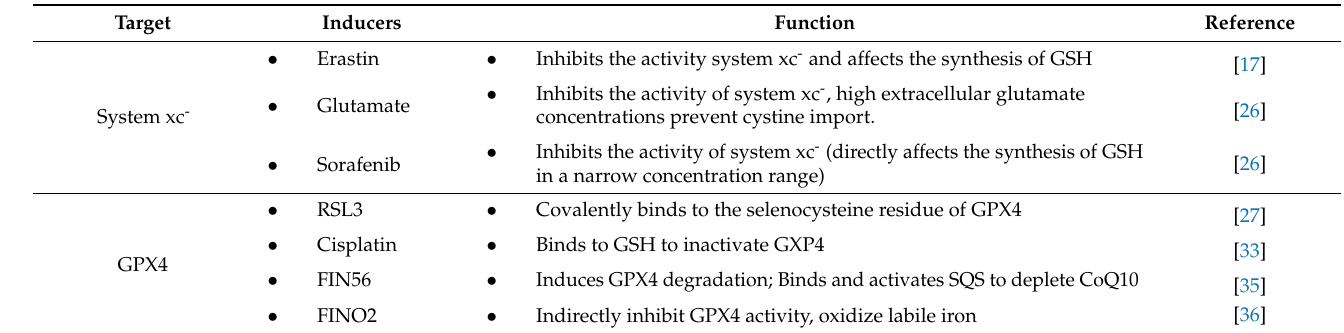
receptor 1; NCOA4, nuclear receptor coactivator 4; ATG5, autophagy-related 5; ATG7, autophagy-related 7; PUFAs, polyunsaturated fatty acids; PUFA-CoA, polyunsaturated fatty acyl-coenzyme a; PL-PUFA, polyunsaturated phospholipid; ALOX, lipoxygenase; LPCAT3, lysophosphatidylcholine acyltransferase 3; ACSL4, acyl coenzyme A (CoA) synthetase long-chain family member 4; ER, endoplasmic reticulum. Table 1. Main ferroptosis